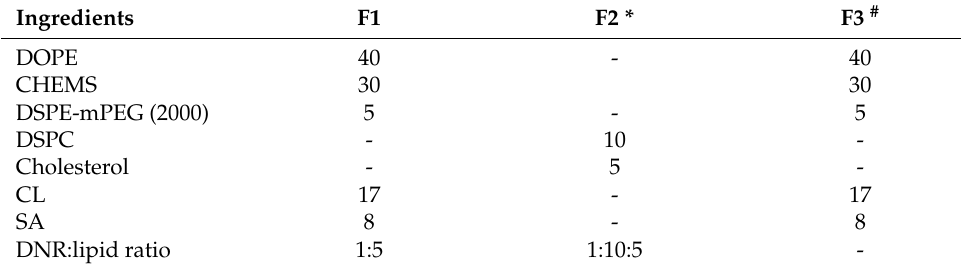
Table 1. Composition and molar ratio of various liposomal